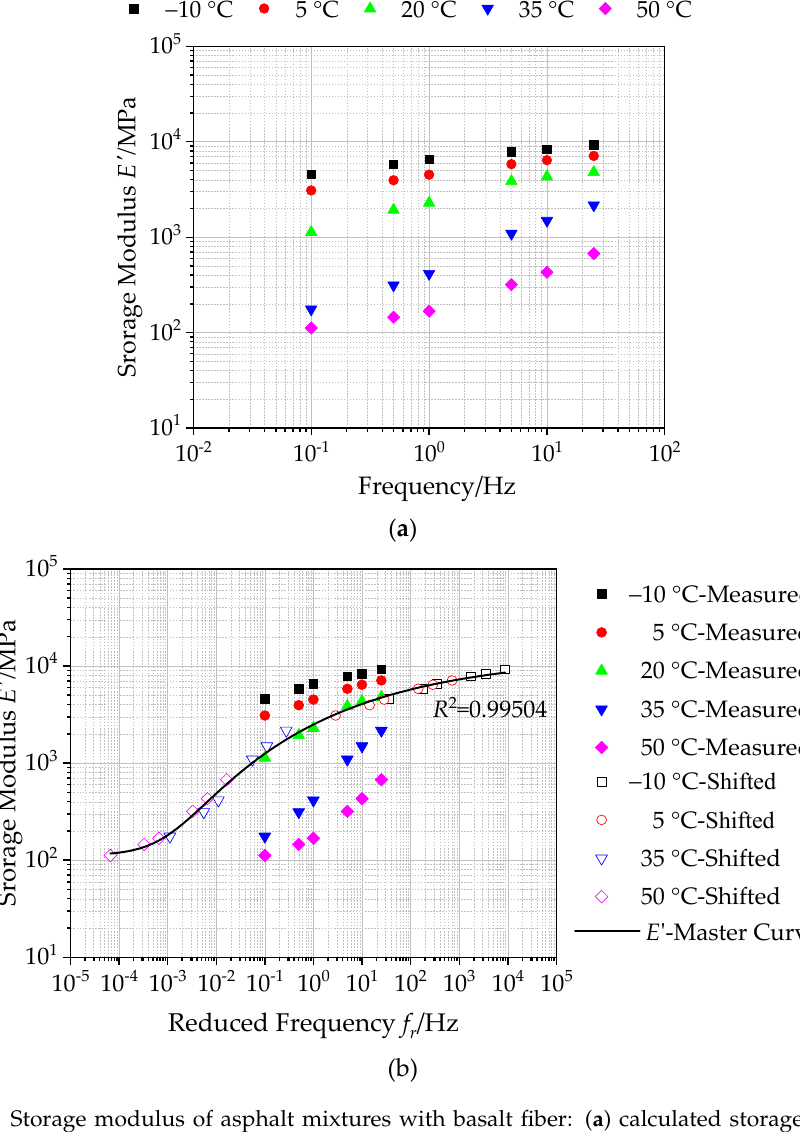
Figure 9. Storage modulus of asphalt mixtures with basalt fiber: ( a ) calculated storage modulus, ( b ) master curves of storage modulus (reference temperature = 20 °C).